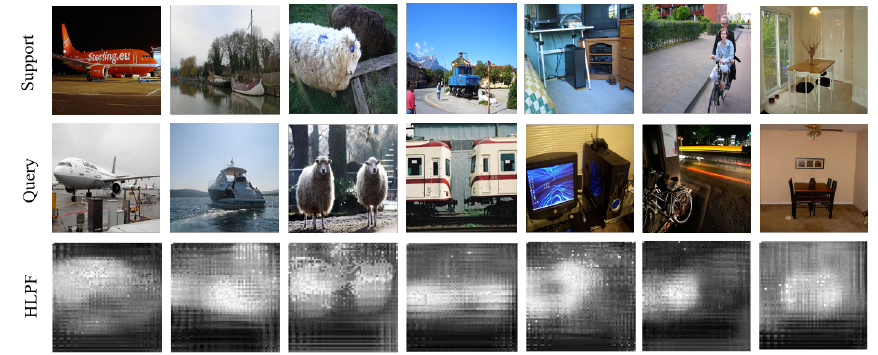
Figure 4. Visual illustration step of query feature enhancement module.